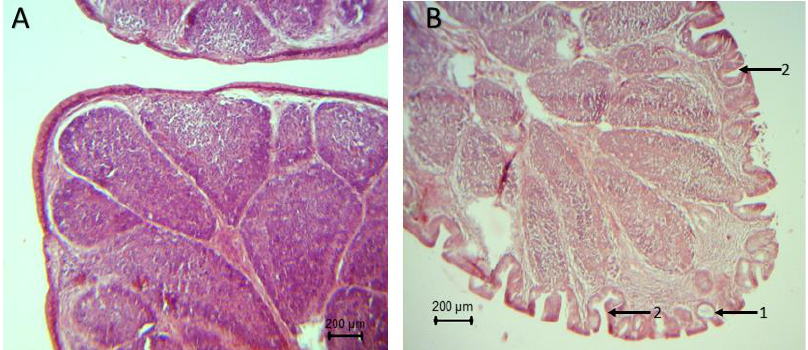
Figure 2. Histopathological lesions in the bursa of broilers challenged with S. typhimurium and C. perfringens. ( A ): Bursa without apparent lesions (control group) (4 × ). ( B ): (1) intraepithelial mucosal cysts, (2) epithelial invaginations (S. typhimurium + C. perfringens) (4 × ).